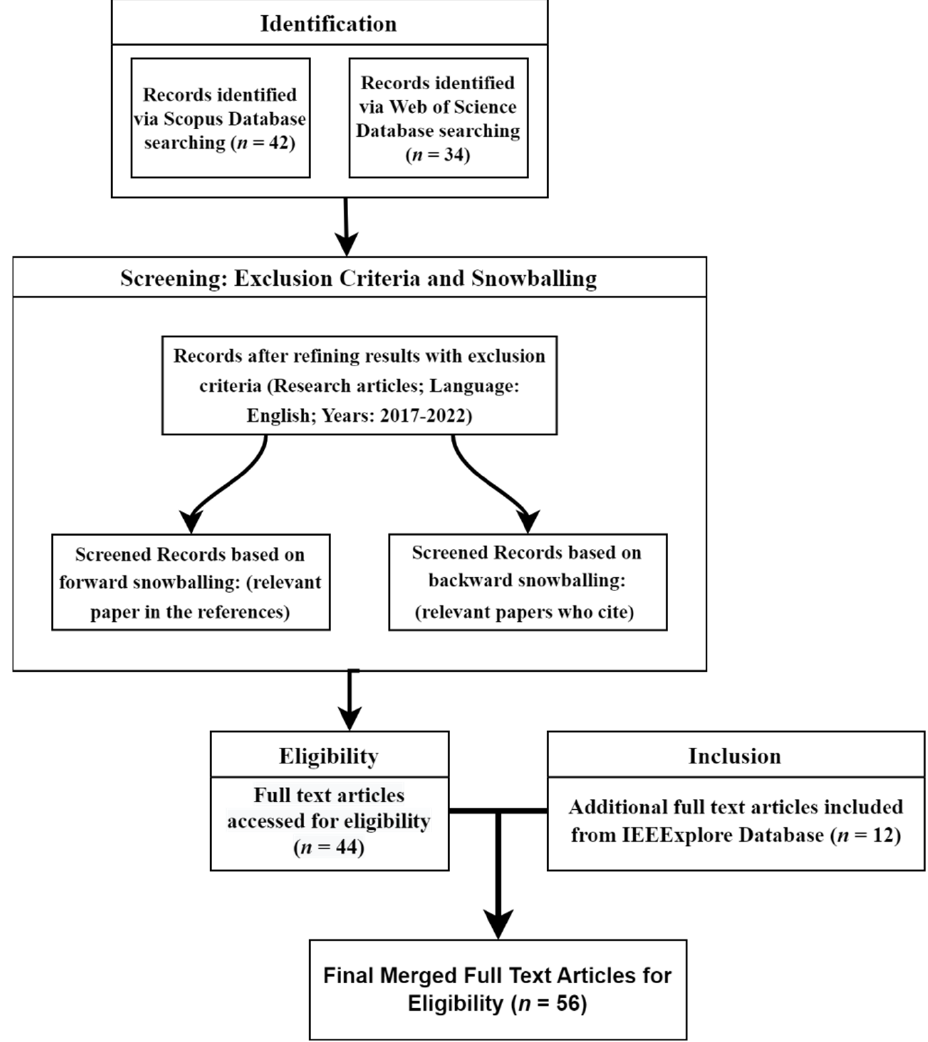
Figure 2. PRISMA workflow for article selection and retention in each step.